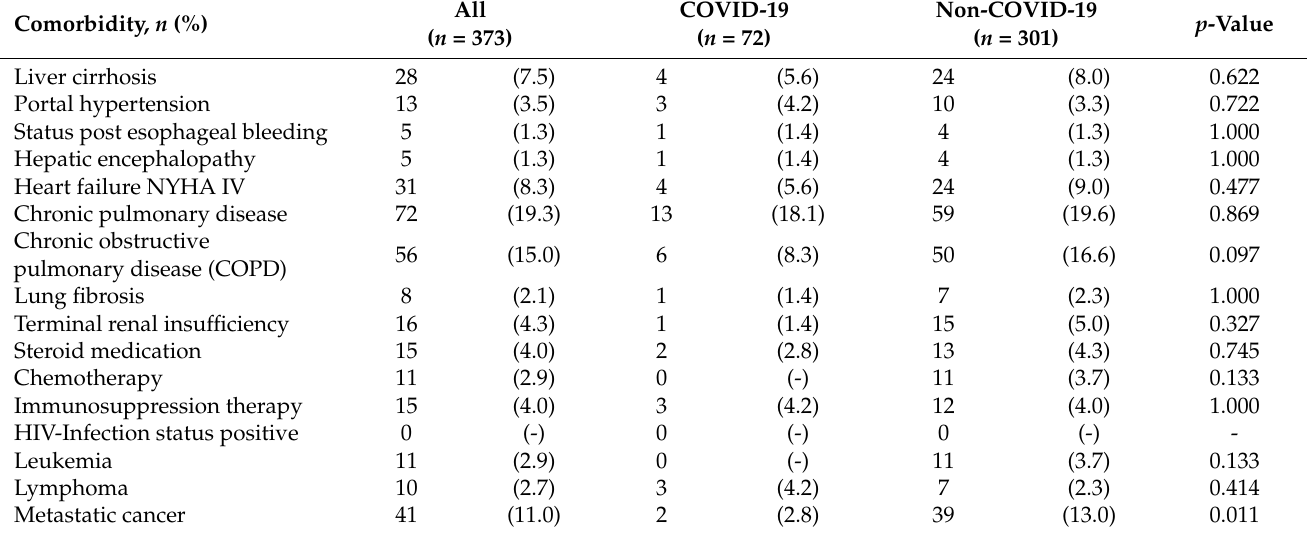
Table 2. Patient